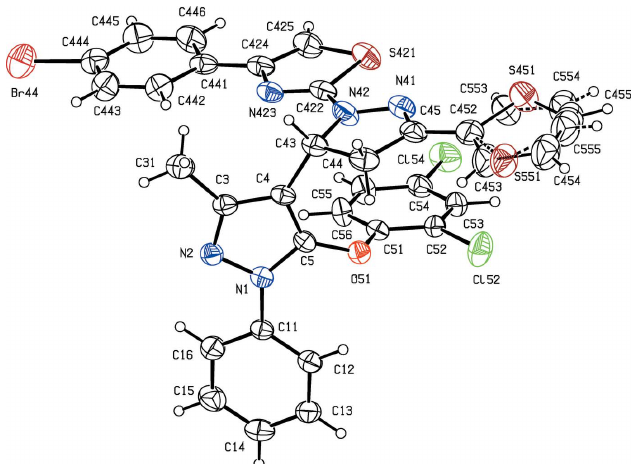
Figure 4 The molecular structure of compound (III) showing the atom-labelling scheme and the disorder in the thiophene unit, where the major disorder component is drawn using full lines and the minor disorder component is drawn using broken lines. Displacement ellipsoids are drawn at the 30% probability